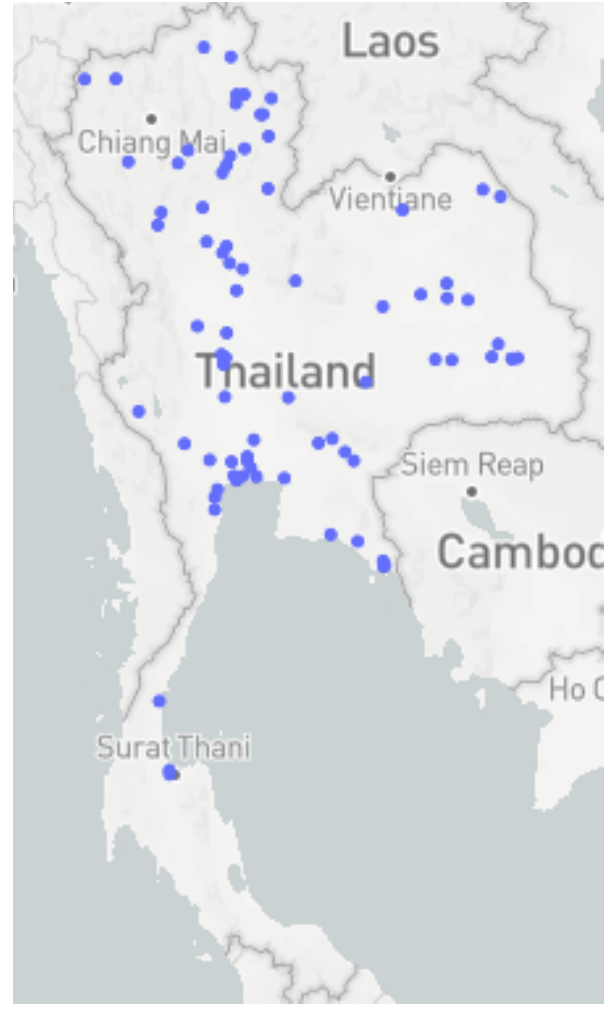
Figure 2. Locations of all 81 stations used as our case